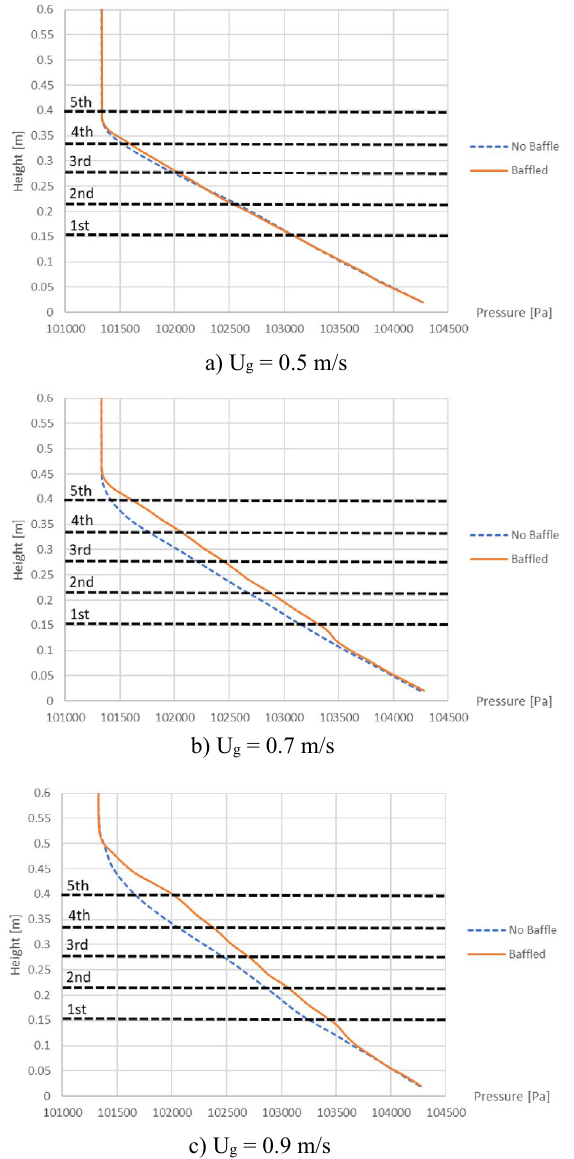
Figure 20. Time-and-area-averaged pressure before and after installing the baffles in case that biomass was fed at middle, when operating with various gas inlet